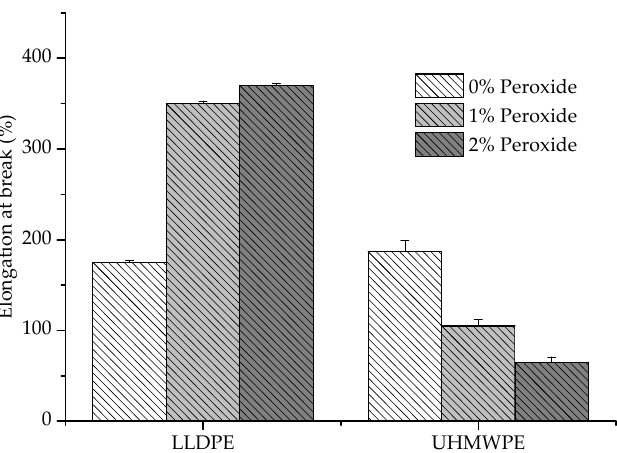
Figure 6. Deformation at the rupture of LLDPE and UHMWPE with 1% and 2% peroxide.